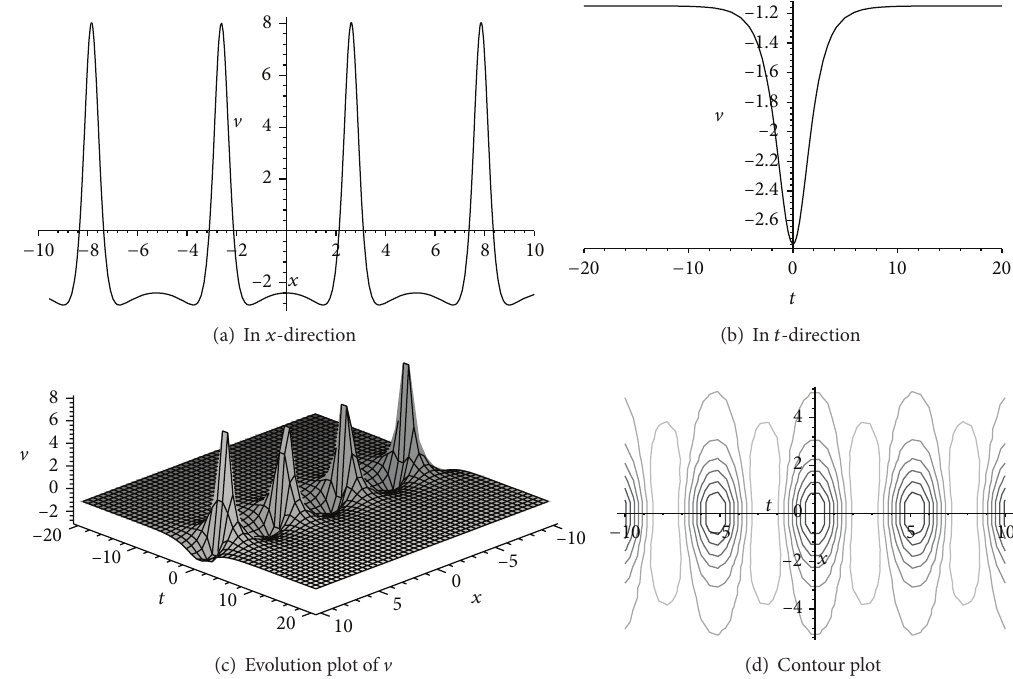
Figure 4: The periodic-solitary wave solution V (𝑥,𝑡) given by (27) with 𝛿 = 0.4 , 𝛽 = 2.0 , 𝜆 = 1.2 , and 𝑚 = 0.8